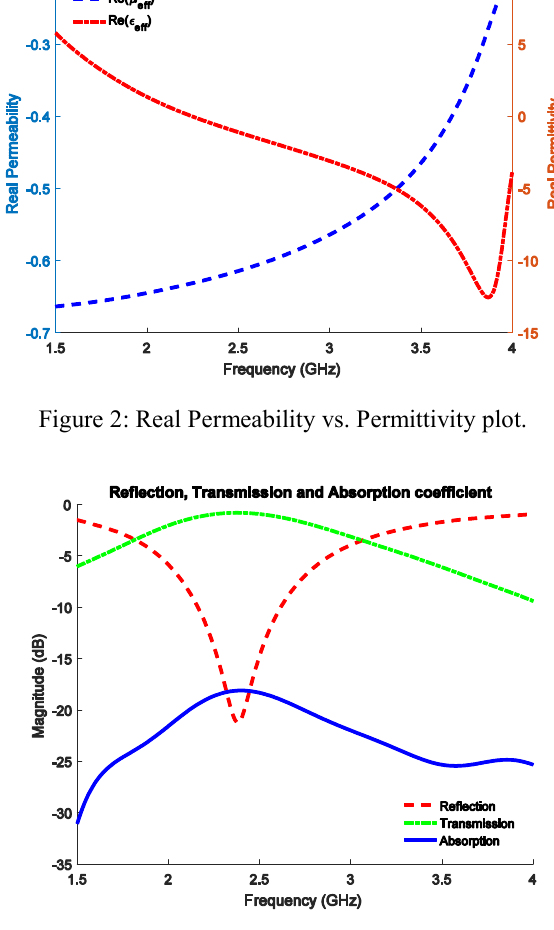
Figure 3: Reflection, Transmission and Absorption magnitude of the